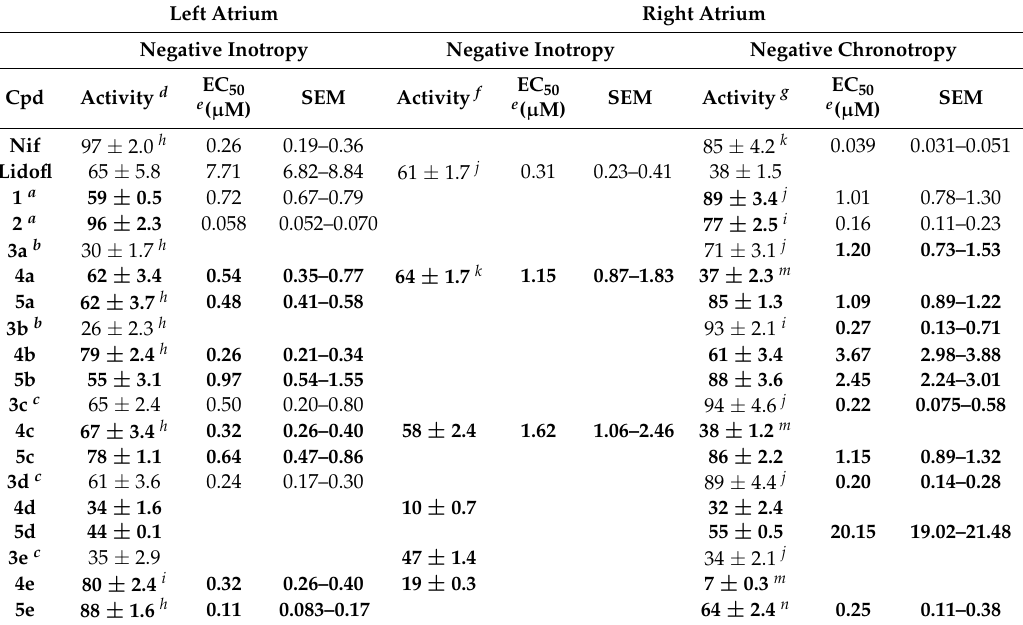
Table 1. Cardiac activity of the tested